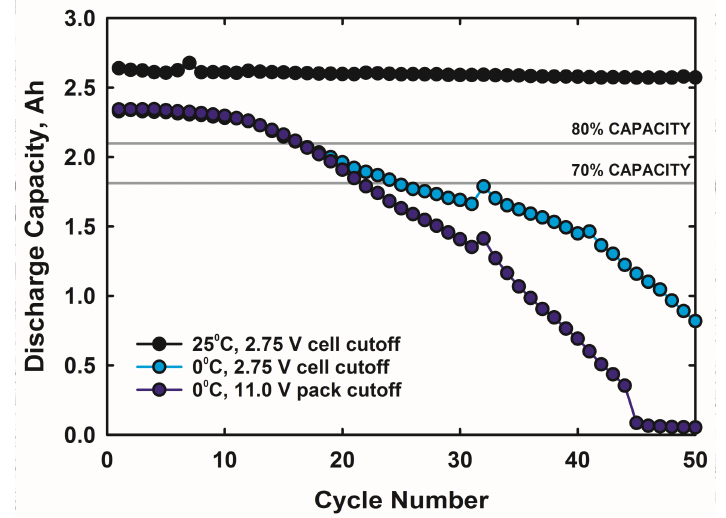
Figure 6. Battery pack capacity loss at 25 ◦ C and 0 ◦ C with discharge cutoffs when the first cell reaches 2.75 V and when the pack reaches a voltage of 11.0